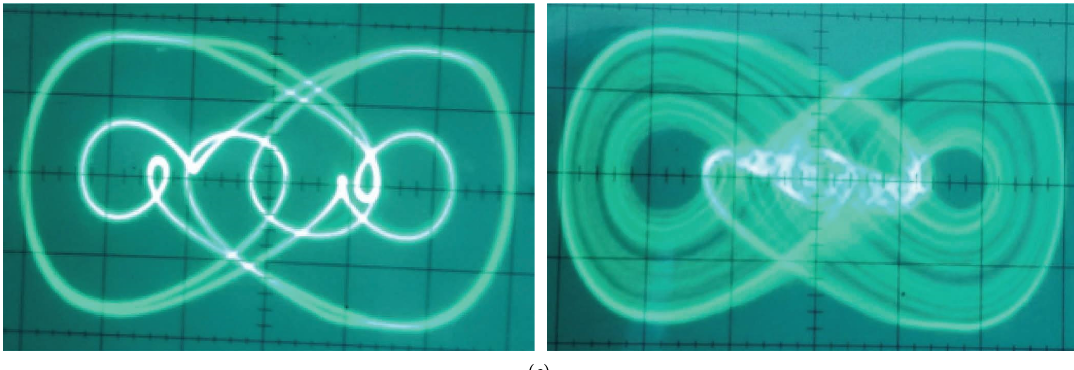
Figure 5: Diferent phase portraits of the system. (a) MATLAB curves obtained with parameters of Figure 4, (b) PSpice results, and (c) the experimental simulations of the system. Te curves of Figure 5 (c) are obtained from the circuit of Figure 2. Tese curves display the multiperiodic states (left hand side-lhs) and the chaotic behaviors (right hand side-rhs) of the system. Te values of the parameters are defned as: ξ � 0 . 1, ω � 1 . 35, F � 26, α � 1 R